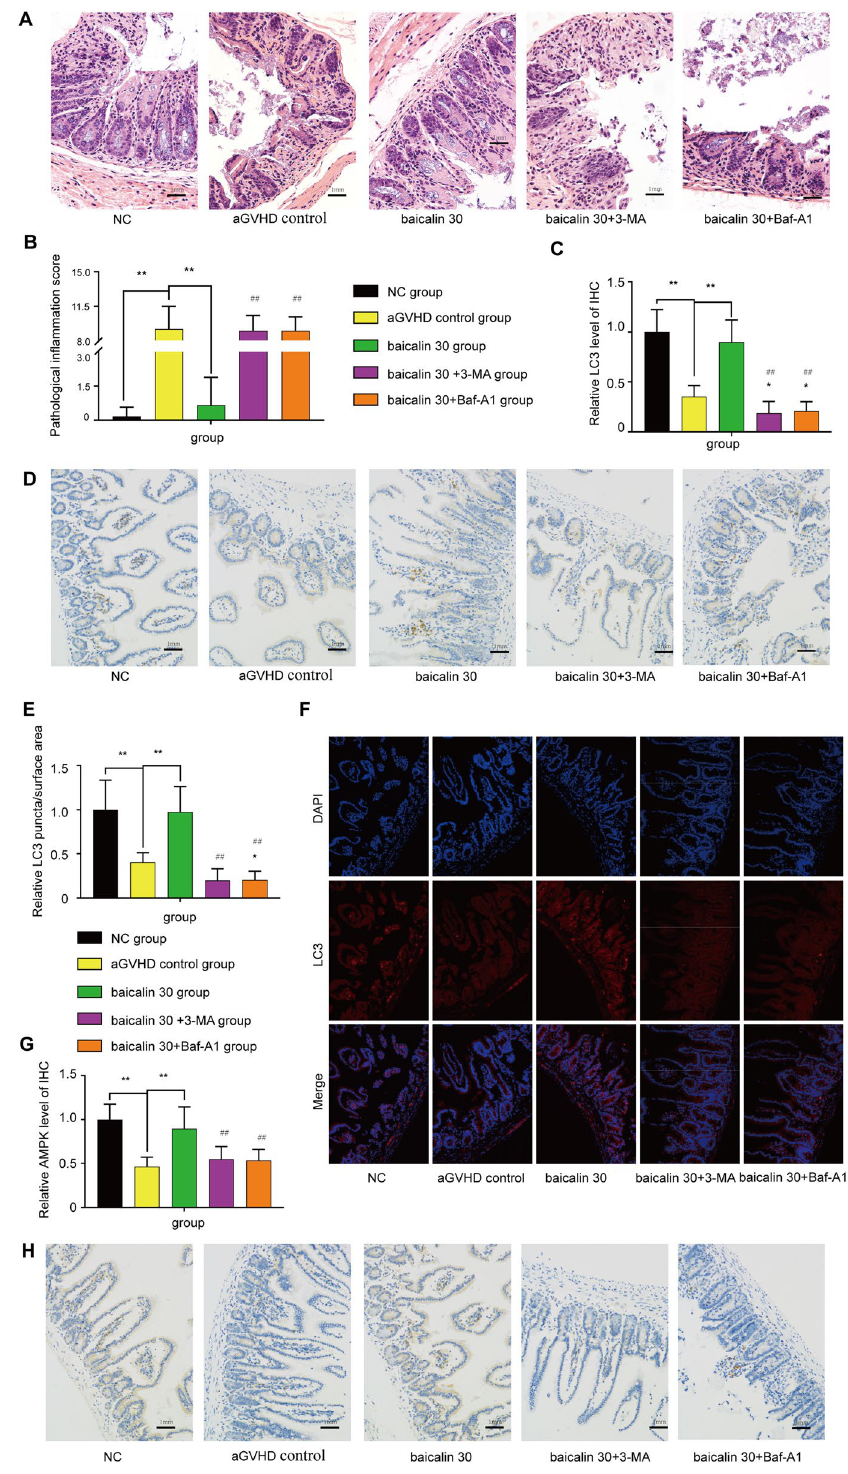
Figure 3. Pathology, IHC and LC3 levels of the small intestine. On the 15th day, samples were collected for testing. ( A ) Representative intestinal histological images from each experimental group (H&E staining, 200 ×). ( B ) Mouse small intestine pathological score. ( C ) Assessment of LC3 levels. ( D ) IHC staining for LC3 in different groups. ( E ) Assessment of immunofluorescence staining for LC3. ( F ) Immunofluorescence staining for LC3 in different groups. ( G ) Assessment of AMPK levels. ( H ) IHC staining for AMPK in each group. Each experiment was repeated three times. Note: * P < 0.05 and ** P < 0.01 compared with the aGVHD control group. ## P < 0.01 compared with the 30 mg/(kg d) baicalin